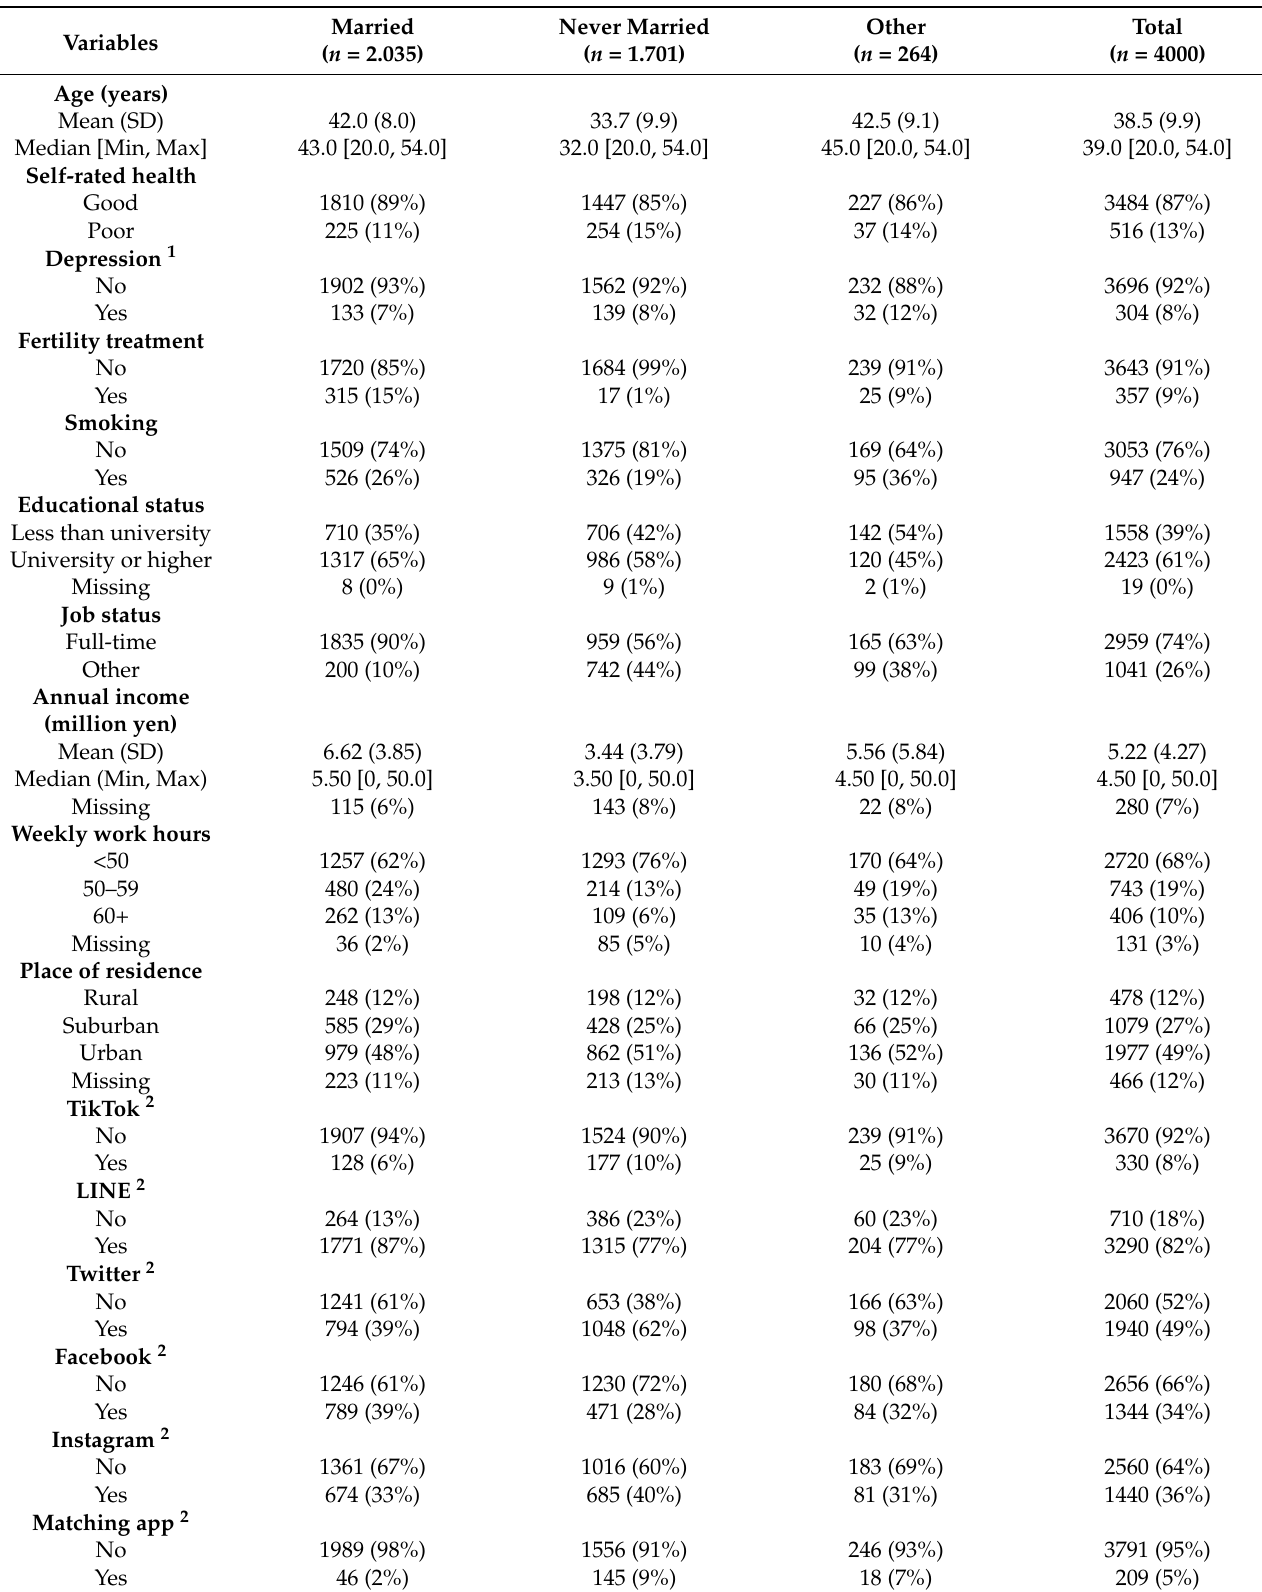
Table 2. Basic characteristics of participants by marital status ( n =